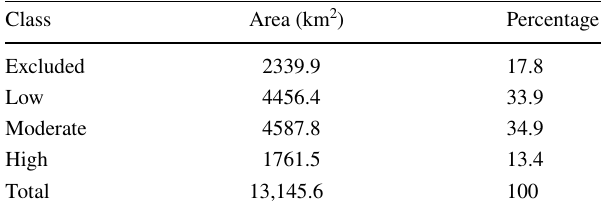
Table 2 The total area for each suitability